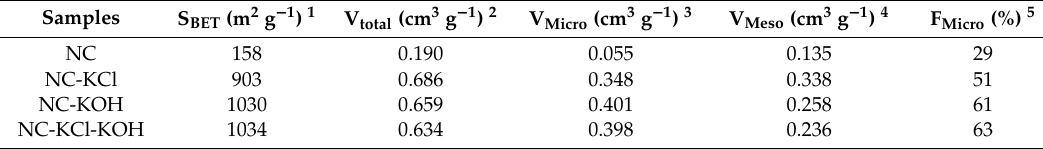
Table 10. BET surface area and porosity of typical samples.